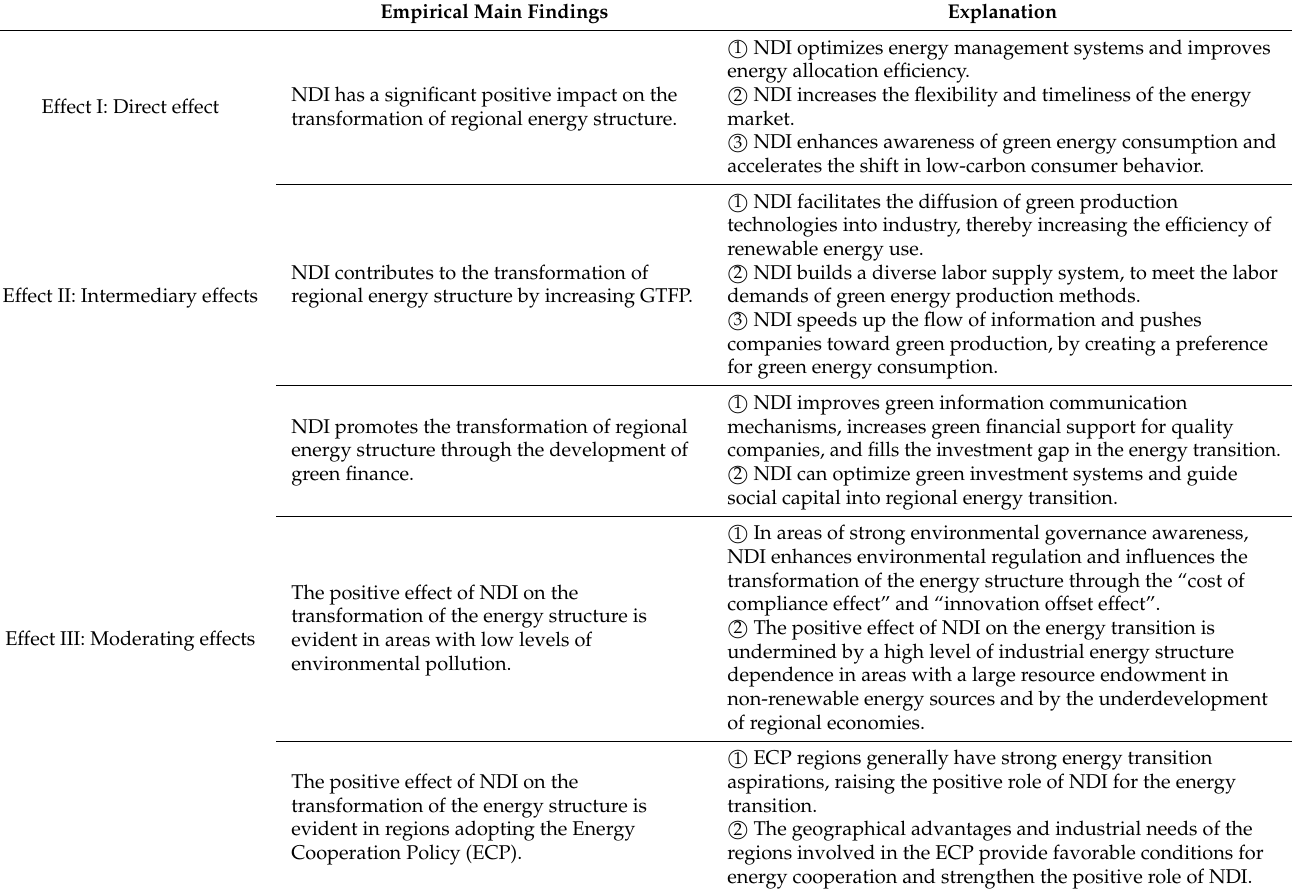
Table 9. Summary of results: three impacts of NDI on energy